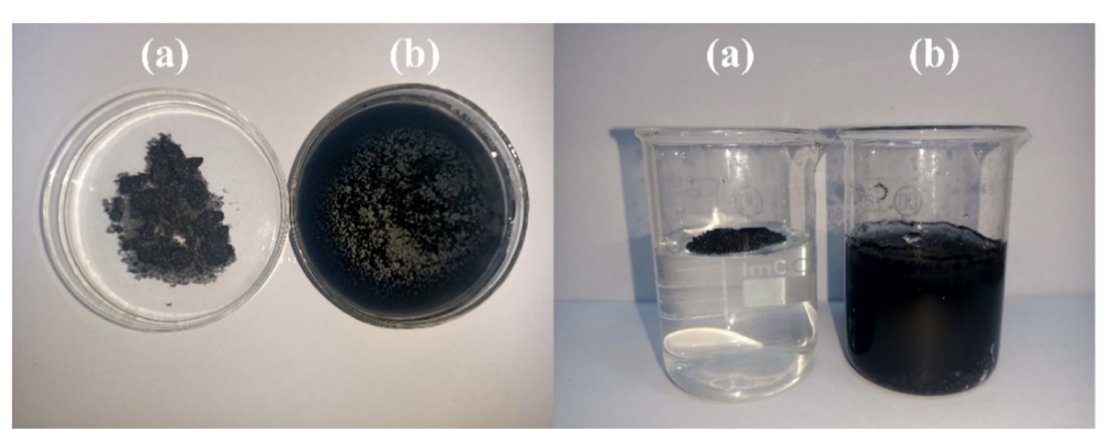
Figure 8. Comparison of hydrophobicity between ( a ) MG and ( b ) microcrystalline graphite. The hydrophobicity of the MG increased markedly compared with that of the graphite, owing to the increase in the number of lipophilic groups on the surface. The improvement of MG lipophilicity was achieved via two stages: chemical modification and physical coating. The surface of the microcrystalline graphite contained hydroxyl groups [36,37] which could be esterified with stearic acid under aluminum chloride catalysis. By ester bonding, the carbon chain of stearic acid was partially distributed on the surface of the microcrystalline graphite, and the chemical modification was completed. During the drying process for microcrystalline graphite, the polymer (after esterification reaction) and stearic acid (without chemical reaction) were gradually precipitated out and coated on the surface of the microcrystalline graphite to produce a physical coating modification. Furthermore, the WM (with different mass fractions of MG) pressed into the films (as shown as Figure 9), and the hydrophobicity of the graphite after modification notably increased, allowing it to be uniformly dispersed in the WM.